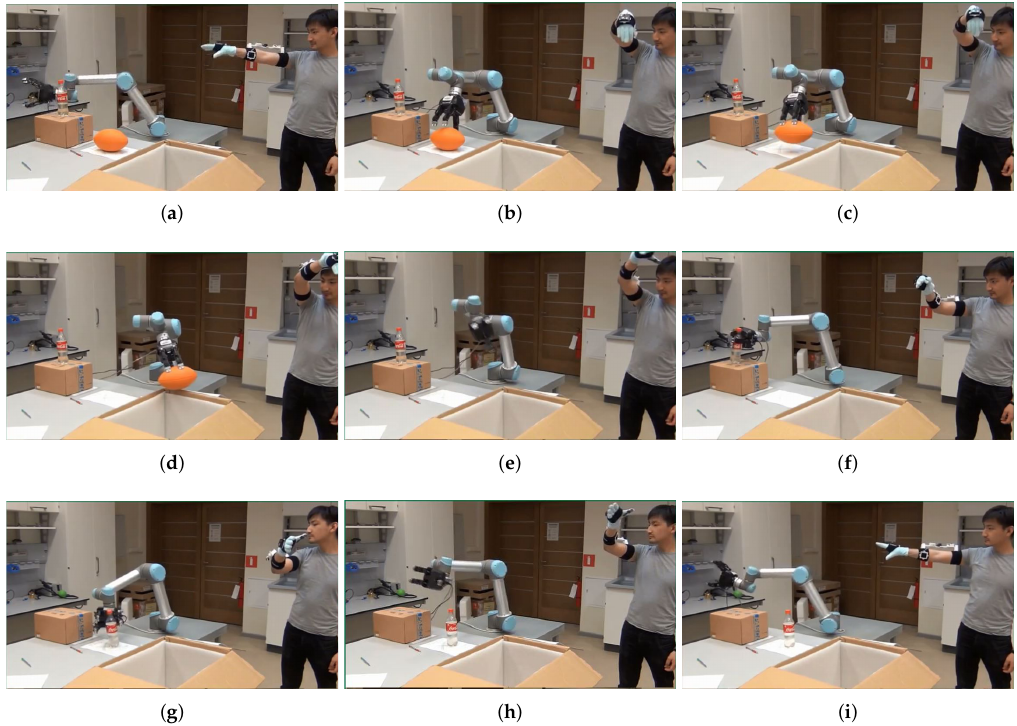
Figure 14. Video frames at nine different time instants during the robot teleoperation experiment using the final arm motion tracking system prototype: the operator assumes the T-pose for initializing the arm motion-tracking system ( a ) and aligning it with the robot, the robot follows the operator’s arm reference ( b ), grasps ( c ), carries towards ( d ) and drops ( e ) the orange ball into an carton box near